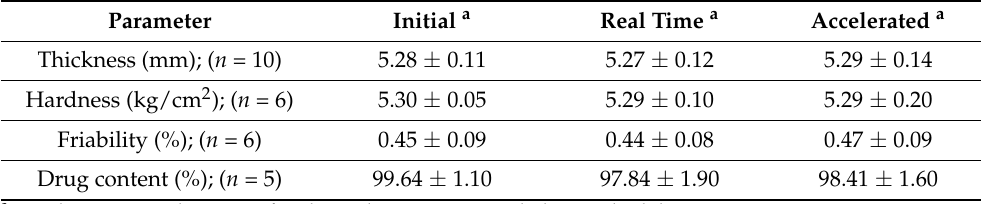
Table 4. Stability data at the end of three months for acyclovir SR